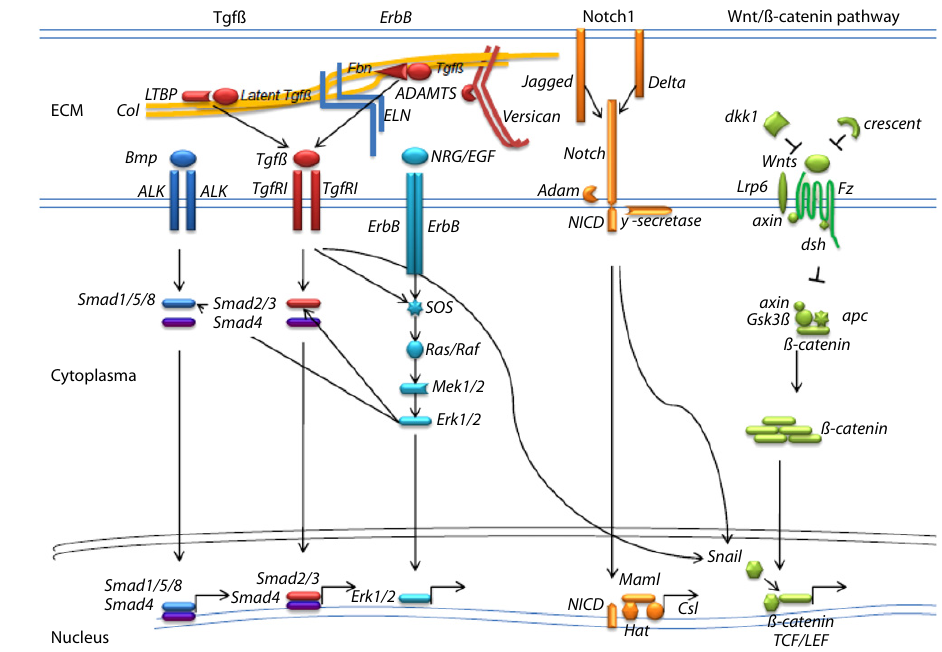
Figure. 2 Signalling networks in valve development. Several transcription factors, extracellular matrix proteins as well as signalling factors have been identified to play a role in valvulogenesis; the TGF β , NOTCH, ERBB and the WNT/ β -CATENIN pathway. Aberrant expressions of individual factors during early and late events result in valvular